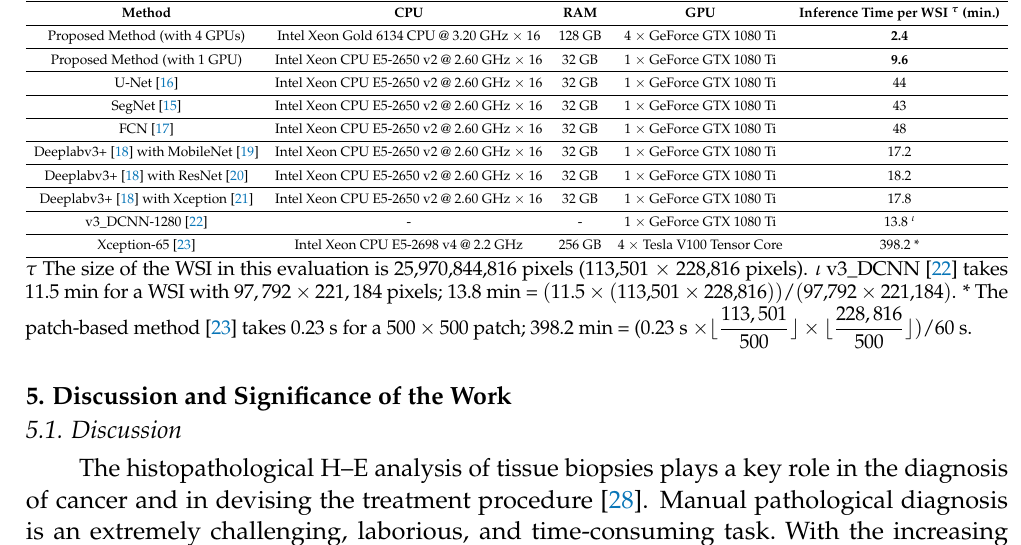
Table 3. Comparison of hardware and computing